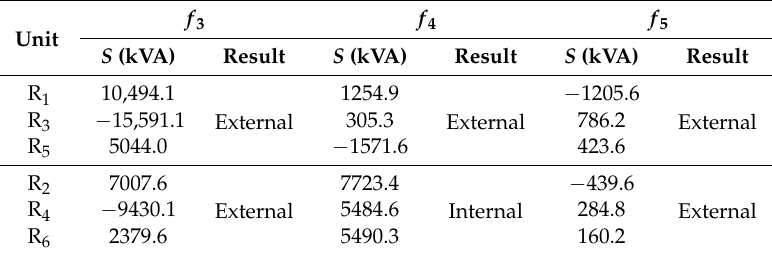
Table 8. Simulation data for the series